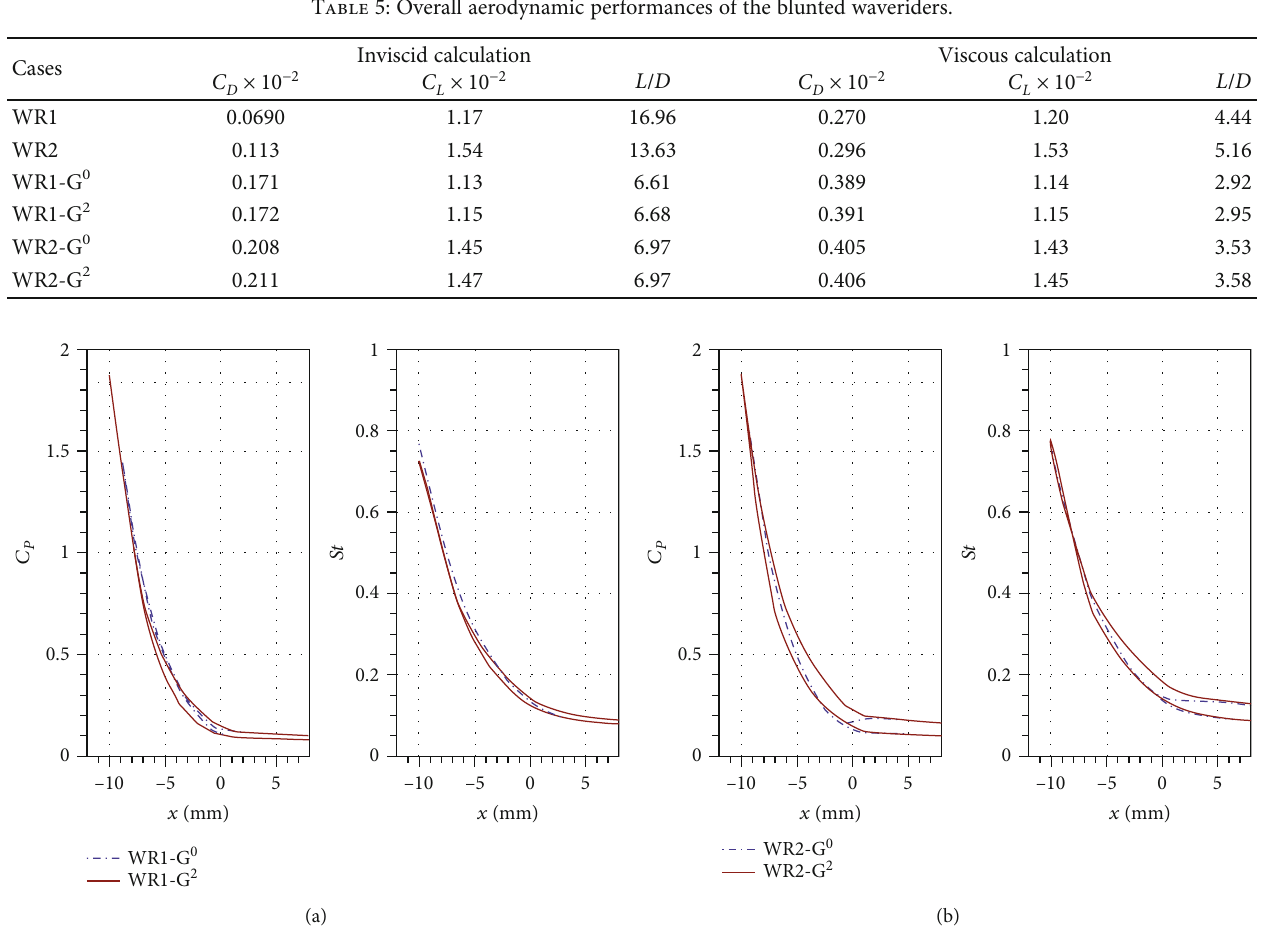
Figure 12: Surface characteristics on the central blunt curve: (a) comparison between WR1-G 0 and WR1-G 2 ; (b) comparison between WR2- G 0 and WR2-G 2